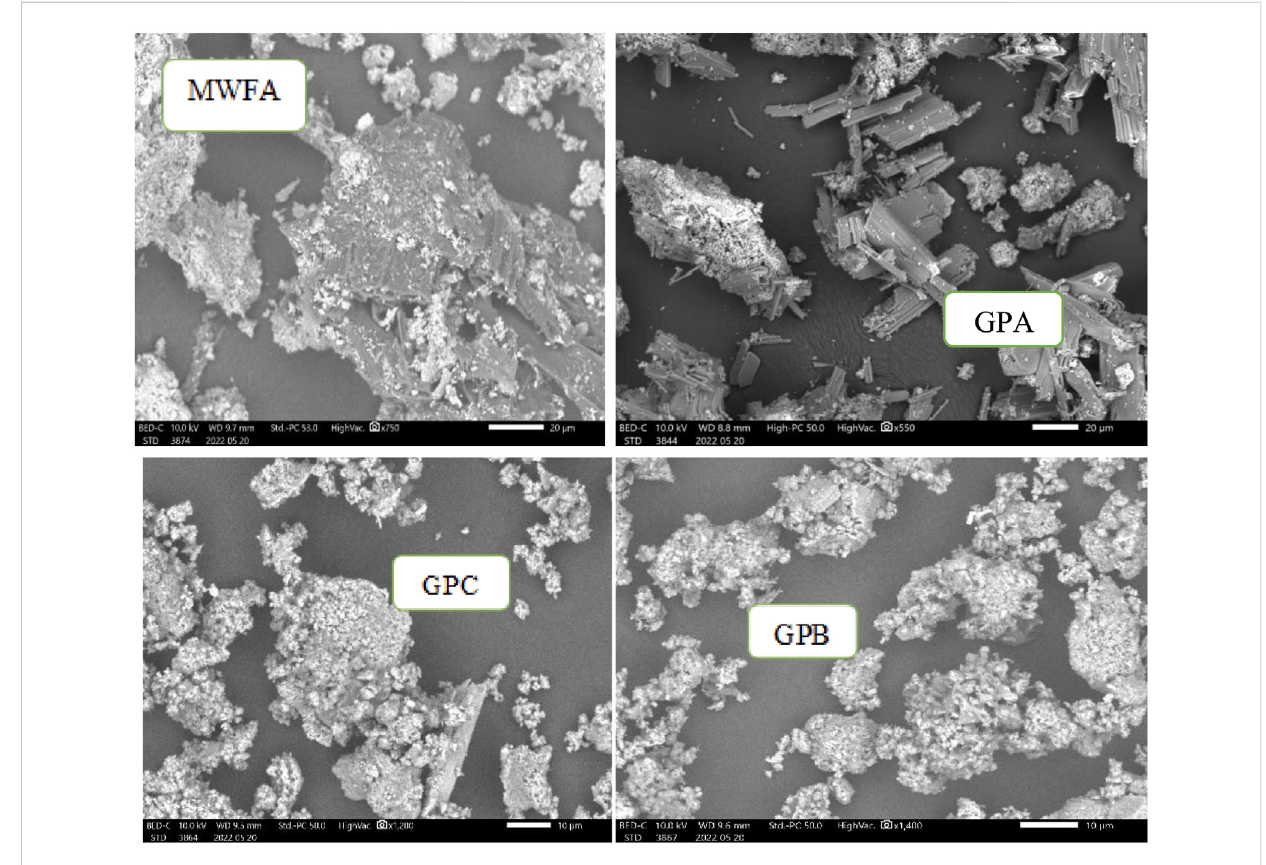
FIGURE 2 SEM images of MWFA (×750), GPA (×550), GPB (×850), and GPC (×1,200).